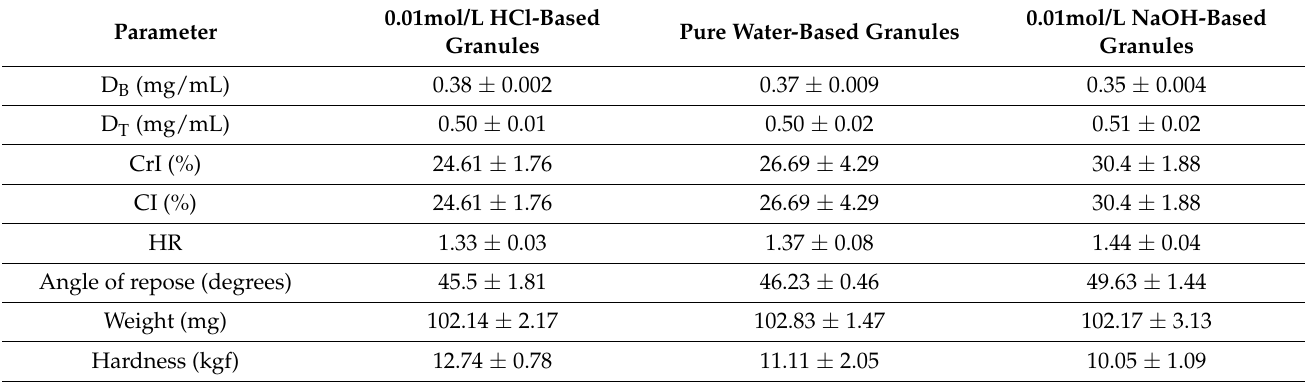
Table 3. Results of flow properties (mean ± SD, n = 3), hardness of tablets (mean ± SD, n = 6).